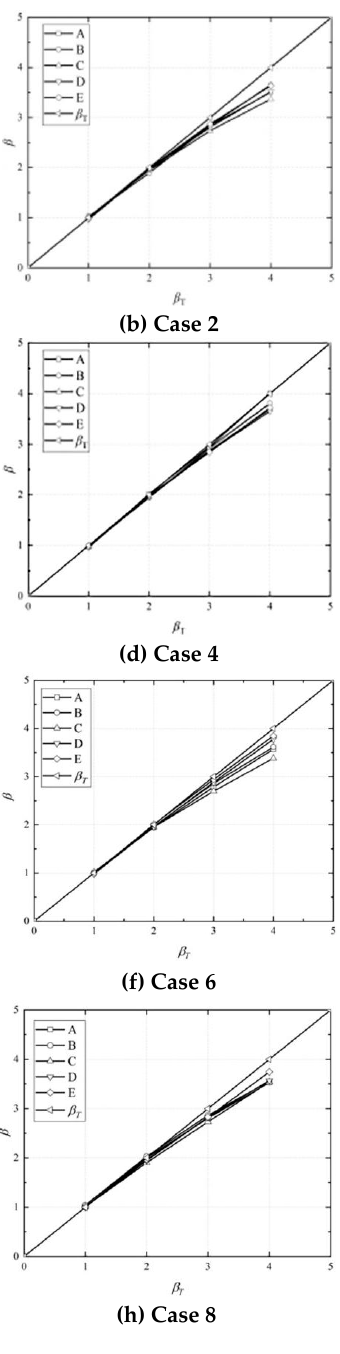
Weibull Table 7. Basic random variable.